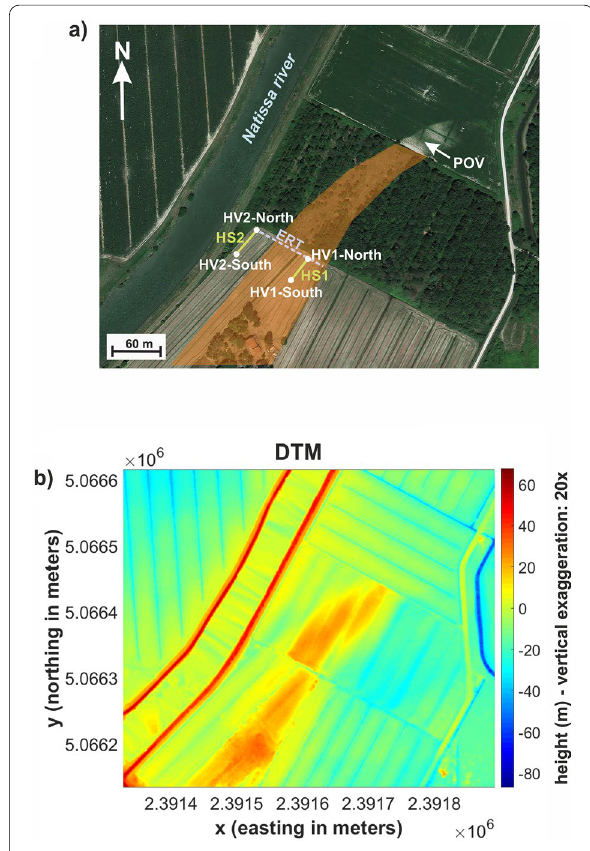
Fig. 8 Beligna#1 area: a detailed map [satellite image] with the location of the geophysical survey (see also Figs. 2a and 3) [the POV arrow indicates the Point of View of the photo shown in Fig. 9a]; b DTM map (vertical exaggeration 20x) that highlights the slightly elevated morphological feature. The two sharp red lines in the western part are the levees of the Natissa River clearly visible in the satellite image. The orange area represents the slightly elevated sandy area (residual